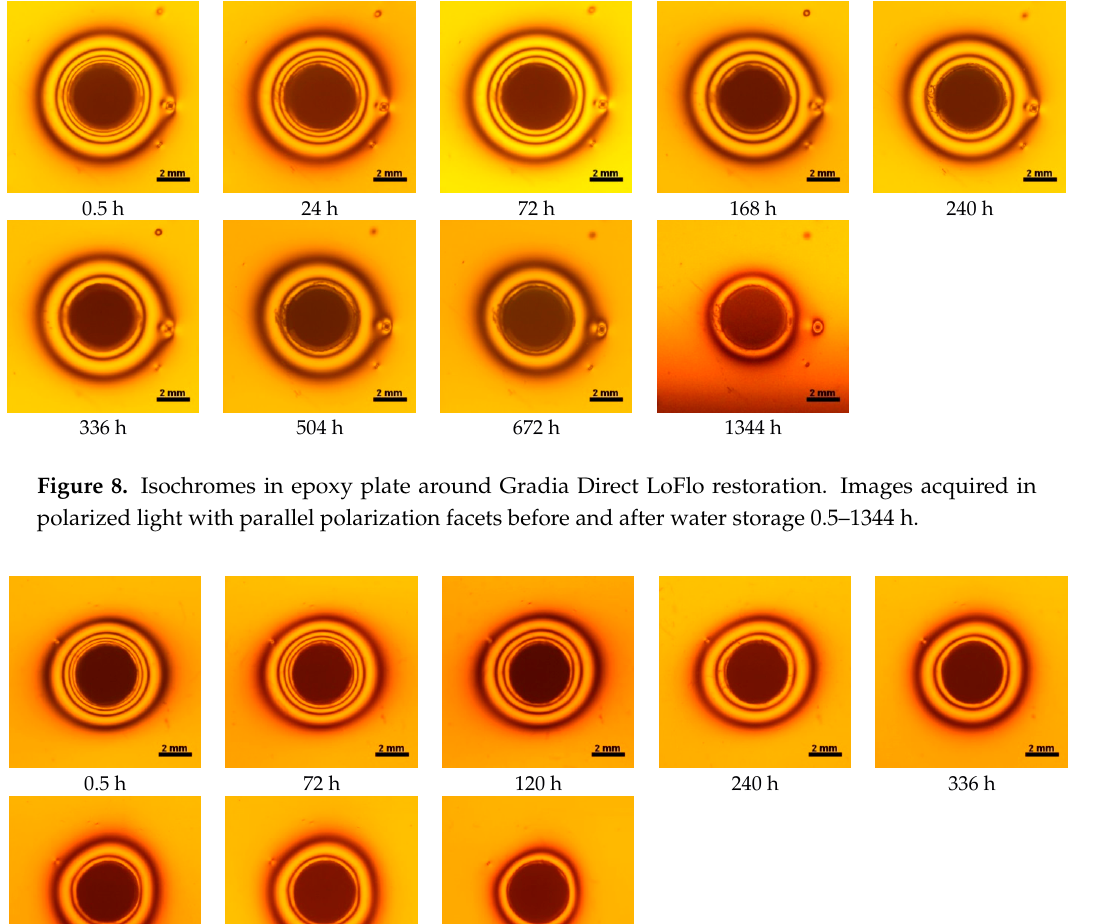
Figure 9. Isochromes in epoxy plate around Filtek Ultimate restoration before and after water storage 0.5–1344 h.